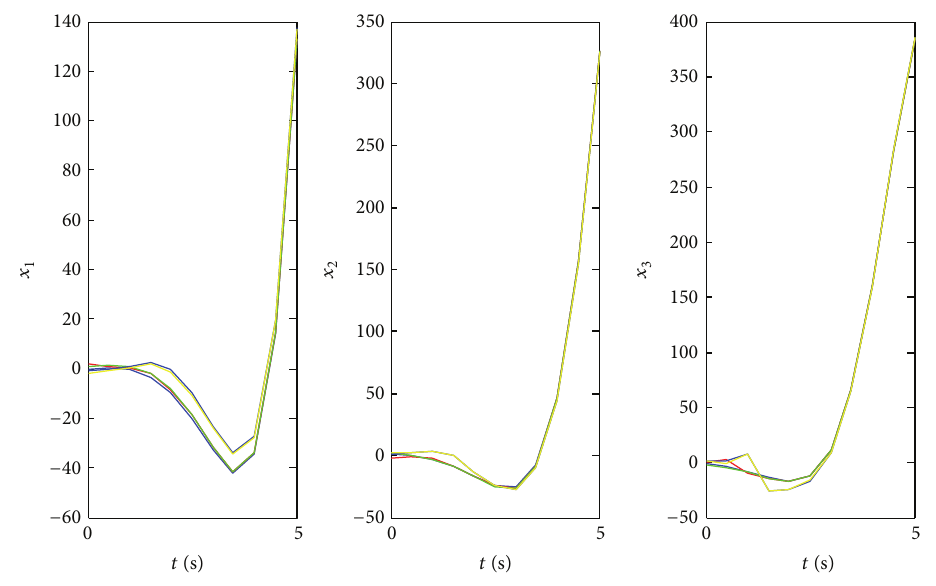
Figure 6: Trajectories of agents under tree-type lossy